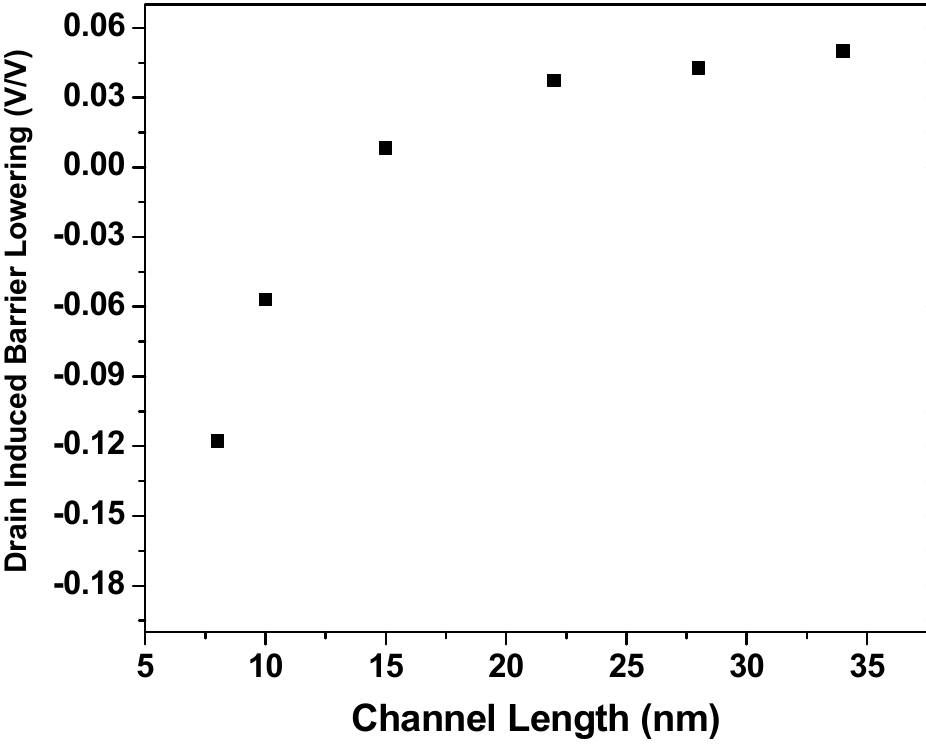
Figure 8. The threshold voltage (in V) vs. Channel length (in nm) at VD = 0.05 V (in a square) and VD = 1 V (in a circle). Note the transition point around 12 nm implying that below this channel length, the Vth of the device at VD,high is lower than that at VD,low.